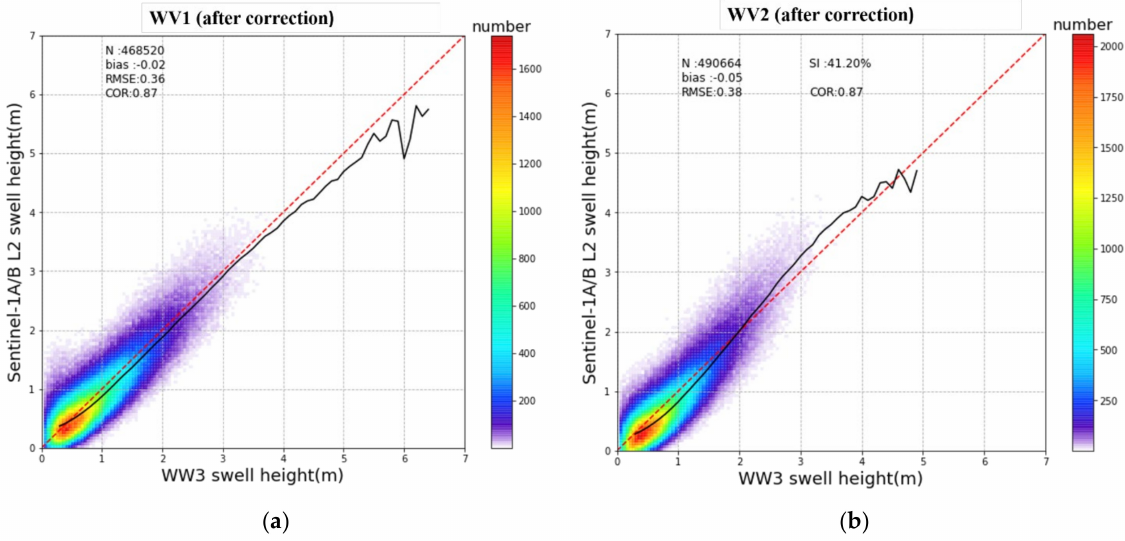
Figure 13. As in Figure 11, but after correction. ( a ) The results with the S-1A/B data in WV1 and ( b ) WV2.